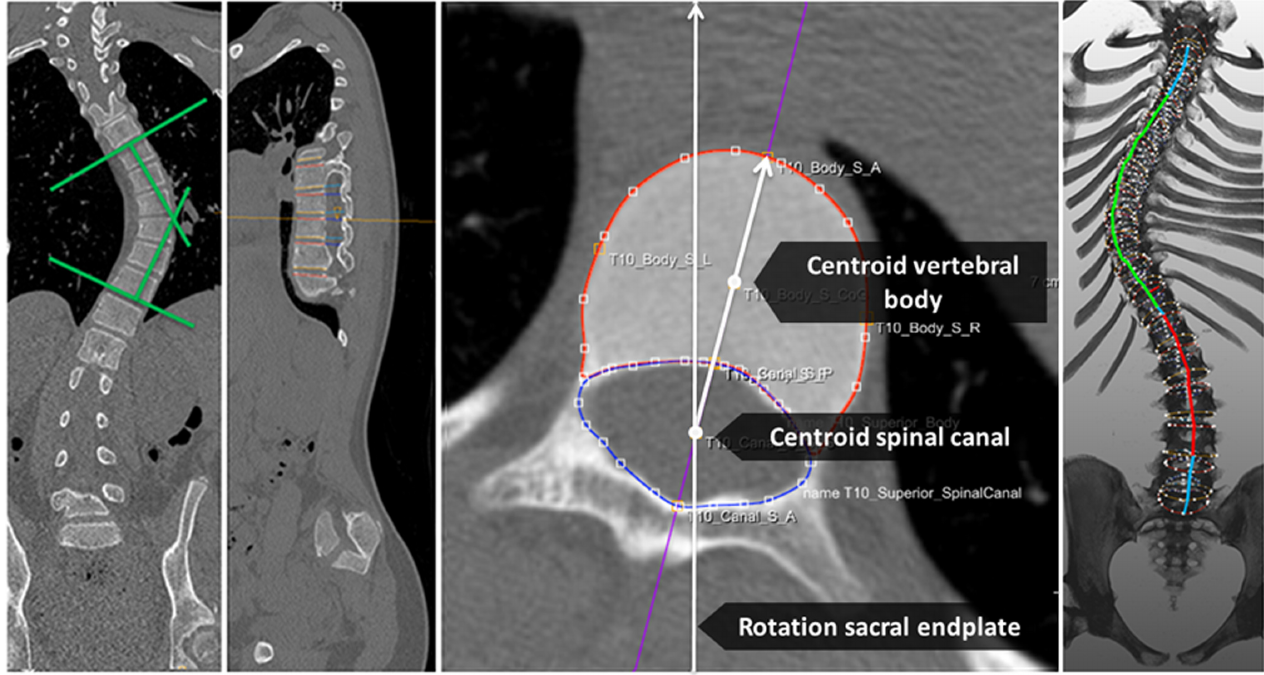
Fig 1. Cobb angle measurements for coronal deviation of the main thoracic and (thoraco)lumbar curve was performed on the coronal slice on which the curve was best visible. Anterior-posterior axis of the endplate was automatically found as the line through the centroid of the spinal canal segmentation and centroid of the endplate segmentation. Based on the anterior-posterior axis, the coordinates of the most anterior and most posterior part of each endplate was found. Length was calculated as a summation of distances between these points for the anterior and posterior aspects of the endplate, and for each vertebra and for each disc, respectively. The total anterior length of the main thoracic curve and (thoraco)lumbar curve are illustrated in green and red on a 3-D spinal reconstruction,